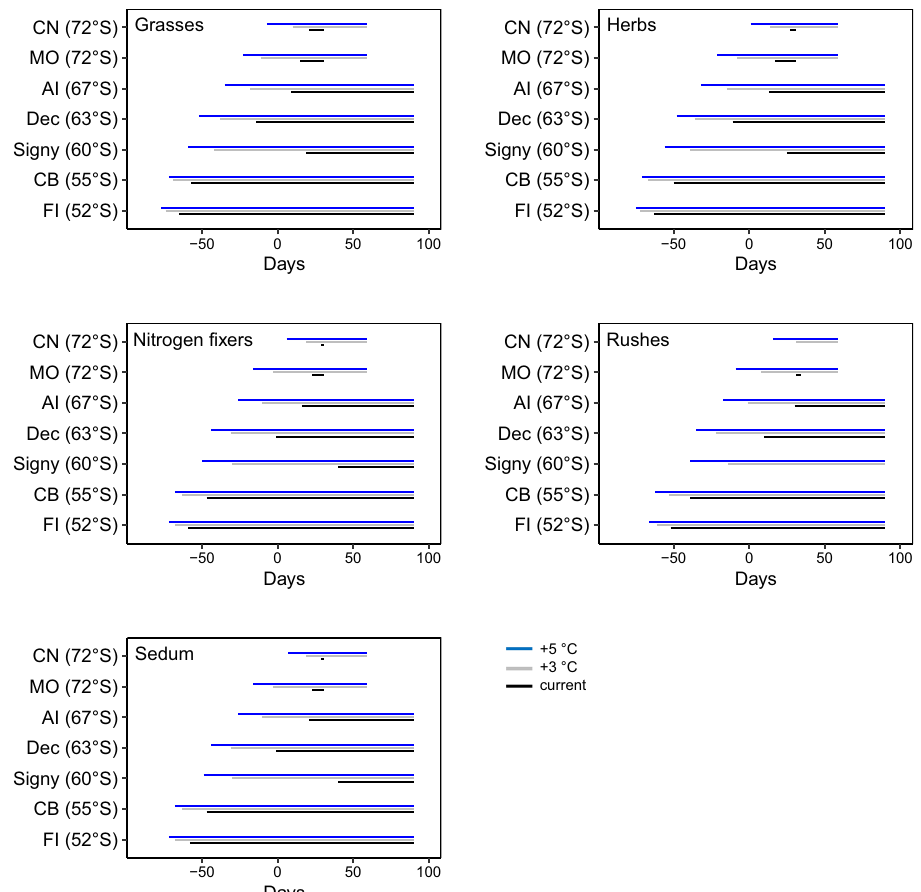
Fig. 3 Potential time available for plant germination and growth in the Antarctic Peninsula. Calculated date of germination and growth duration for different plant types under local soil surface climate conditions and climate warming scenarios at locations from the Falkland Islands (52°S) to Coal Nunatak (72°S). 0-Days = 1st January. Growing season ends on 31st March due to diminishing light conditions at the Falkland Islands (FI), Cerro Bandera (CB), Signy, Deception (Dec) and Anchorage Island (AI), while freezing commences at the end of February at Mars Oasis (MO) and Coal Nunatak (CN) under the climate warming